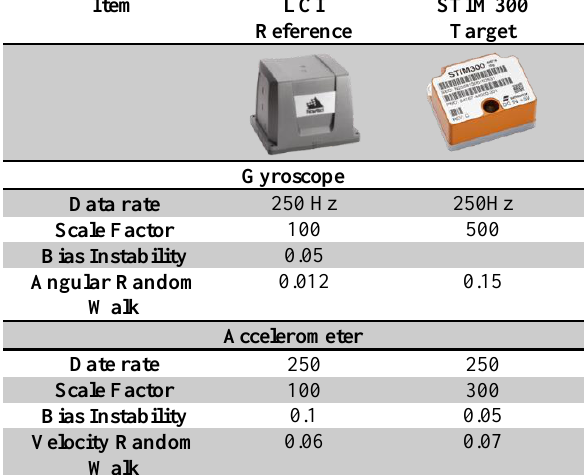
Table 1. Specification of LCI and STIM300